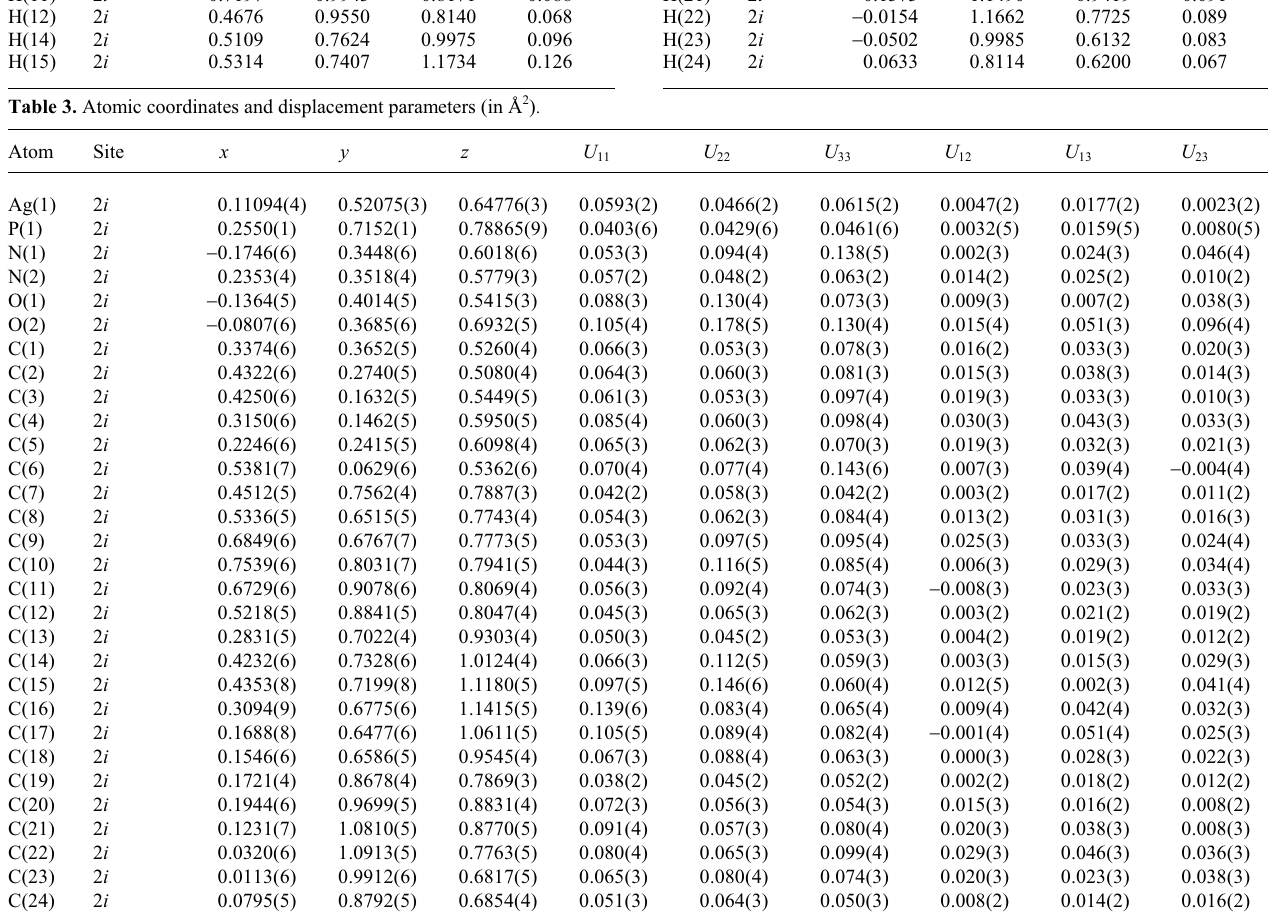
Table 3. Atomic coordinates and displacement parameters (in Å 2 ) .